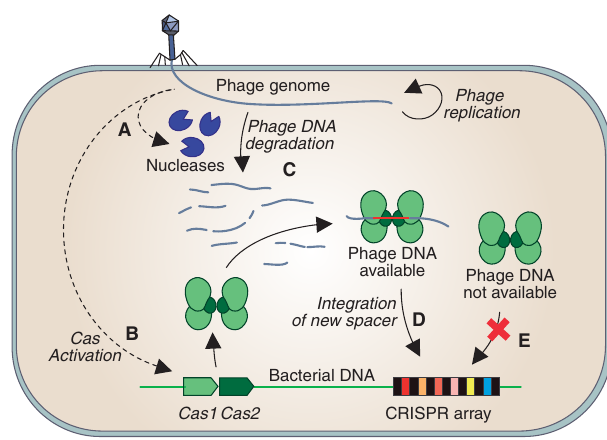
Fig. 5 | Hypothesized model of the inclusion of new phages in the CRISPR memoryofabacterialcell. Thedetectionofaphageinfectioninabacterialcellup- regulatesrestrictionnucleasesthatcleavetheviralDNAatspeci fi crestrictionsites, fostering its subsequent digestion by other bacterial enzymes ( A ). Our model assumesthatCasenzymesareactivated inthelatestagesof theinnateresponseof the bacterial host to the infection ( B ), once the viral DNA has already undergone a certain degree of nuclease-mediated degradation ( C ). New spacers against the infecting phage can only be created bythe host celliffragmentsofits DNAare still presentinitscytoplasmaftertheformationofCas1-Cas2complexes( D ).Otherwise, Cas nucleases have no substrate to act, which prevents the incorporation of the phage into the CRISPR array of the bacterial cell ( E ).